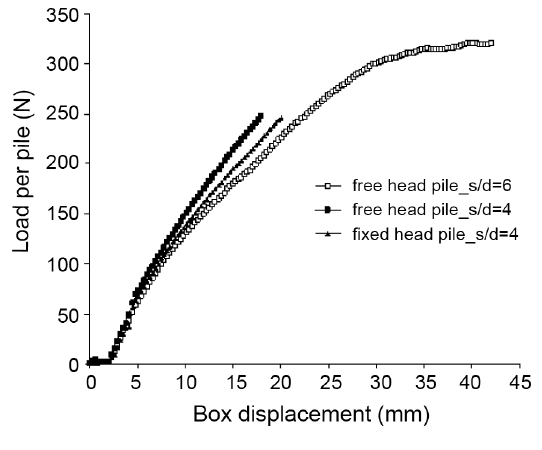
Fig. 9. Load per pile